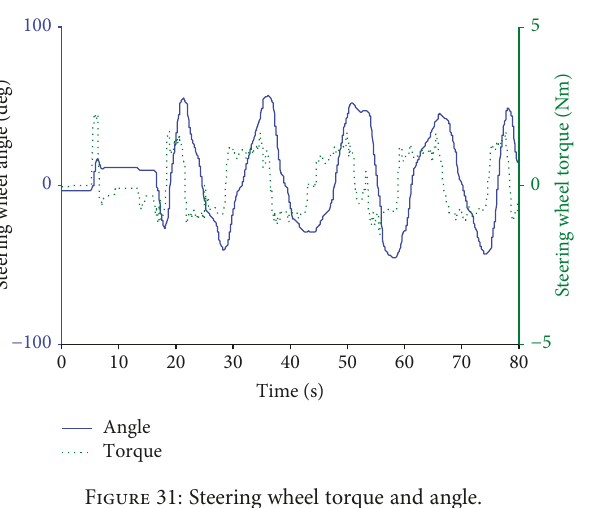
Figure 31: Steering wheel torque and angle.